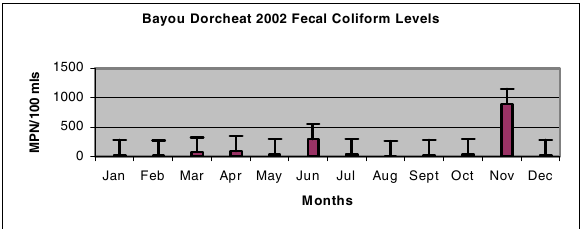
Figure 3: Bayou Dorcheat Fecal Coliform Levels (MPN/100 mls) for 2002.